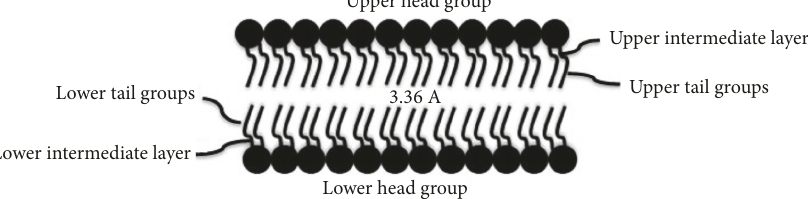
Figure 1: Schematic of the lipid bilayer.